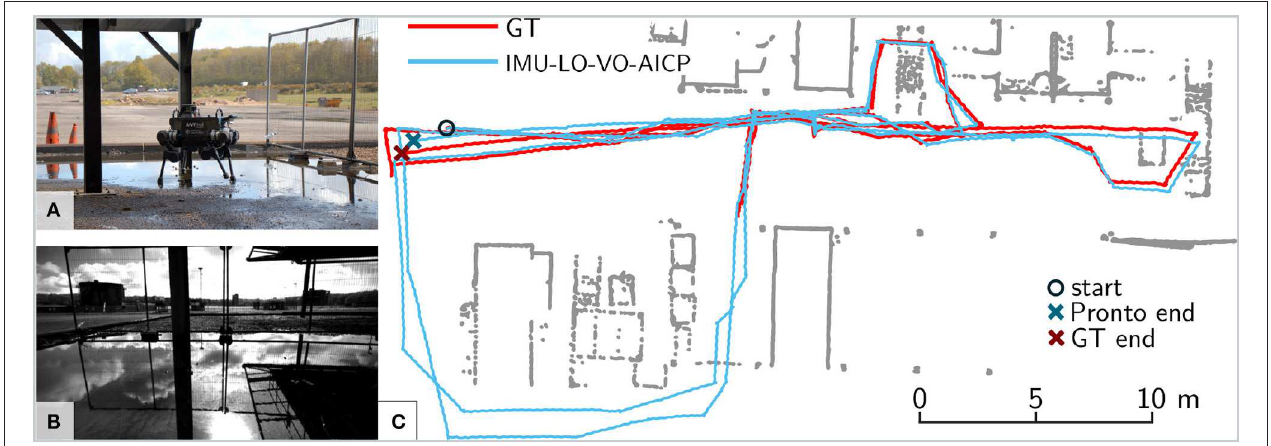
FIGURE 12 | (A) Experiment 7 with the ANYmal robot at the Fire Service College. (B) Onboard camera feed during the experiment. Note the challenging conditions for visual odometry due to reflections in the water. (C) Estimated trajectory from Pronto with FOVIS and AICP active (blue) against ground truth (red). The ground truth was not available in the bottom area. Start and end locations for both algorithms are highlighted with a circle and a cross,